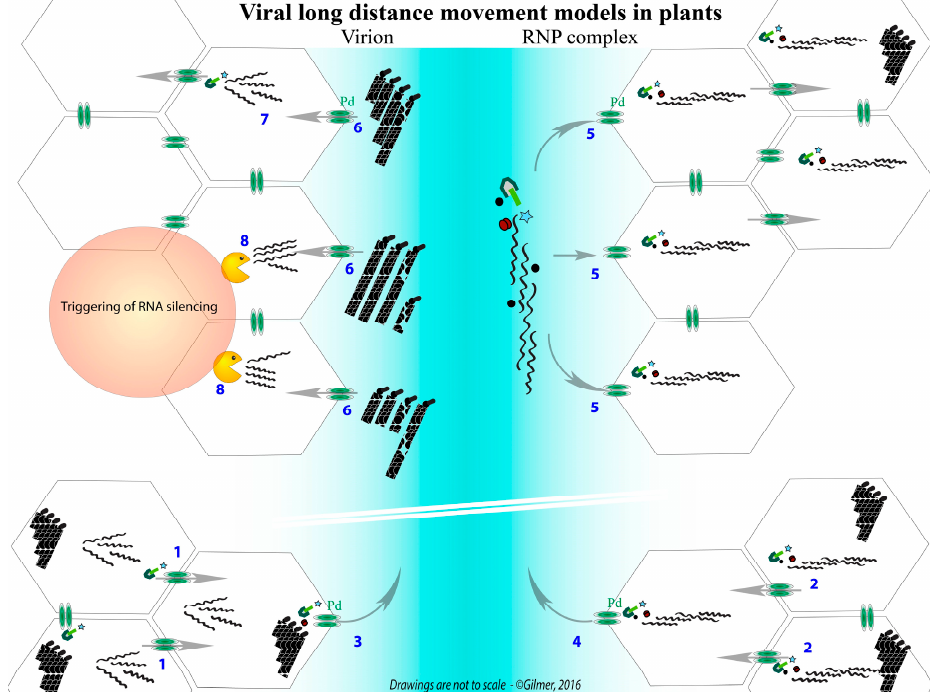
Figure 3. Confrontation of two models describing the long-distance movement of multipartite RNA viruses using the BNYVV as an example. The bottom of the graphic represents the progression of an initial infection of mesophyll cells, wherein the infection progresses thanks to the individual cell-to-cell movement of viral RNAs, driven by TGB movement proteins (1) or as ribonucleoprotein (RNP) complexes involving RNA-RNA network between genomic segments (2). In the sieve elements (blue), the virion (3) or the RNP complexes (4) are transported through plasmodesmata thanks to the viral proteins. RNP complexes, driving the export of the viral genomic RNA network, could provide each distant cell with an entire and fully functional genome ( 5 ). Virions (or single viral RNAs, not presented) are transported in the sieve elements and are randomly distributed in the distant cells ( 6 ). Only the combination providing one of each viral particle (or RNA) is able to initiate an infection that preserves the genome integrity ( 7 ). The particles (or RNA) entering cells without the entire genome are either deficient for replication (not shown) or unable to move from cell to cell and express the VSR, leading to the trigger of RNA silencing ( 8 ).